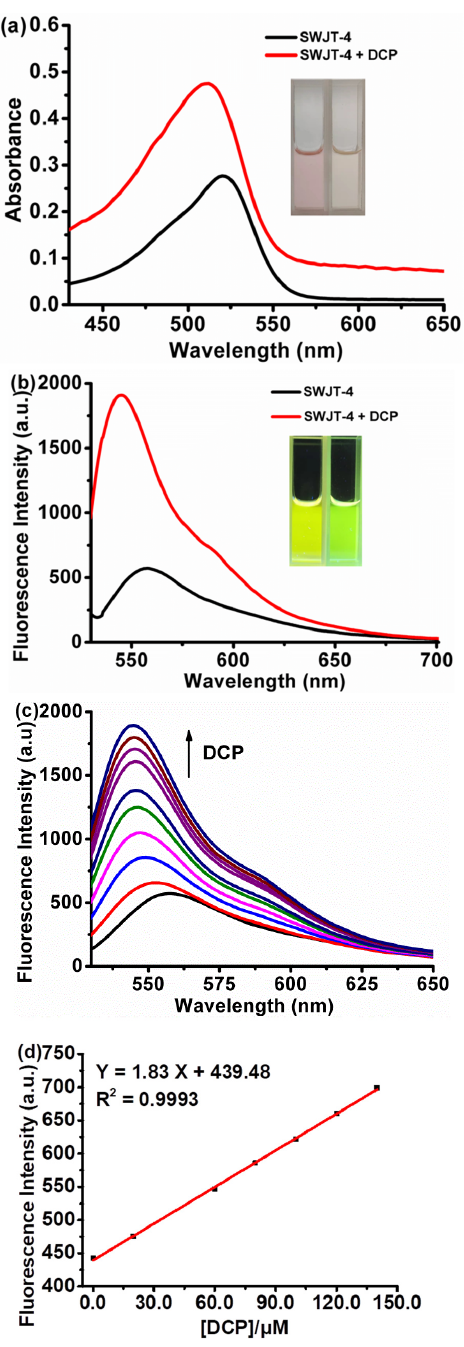
Figure 1. ( a ) The absorption spectrum of SWJT-4 (10.0 µ M) and SWJT-4 + DCP (1.0 mM) in DMSO– HEPES (1/1, v/v , pH 7.4) buffer solution. Inset: the images of SWJT-4 and SWJT-4 after addition of DCP under visible light. ( b ) Fluorescence spectrum of SWJT-4 (10.0 µ M) and SWJT-4 + DCP (1.0 mM) in DMSO–HEPES (1/1, v/v , pH 7.4) buffer solution. Inset: the images of SWJT-4 and SWJT-4 after addition of DCP under ultraviolet light. ( c ) Fluorescence titrations of SWJT-4 (10.0 µ M) with different concentrations of DCP (0–1000.0 µ M); ( d ) Linear relationship between the fluorescence intensity of SWJT-4 (10.0 µ M) at 545 nm and the concentration of DCP (0–140.0 µ